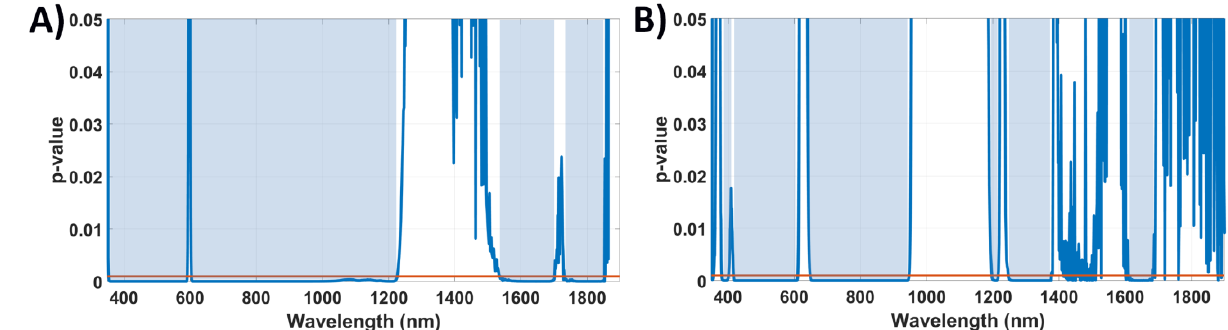
Figure 4. Selected spectral regions (blue) where statistically significant differences ( p < 0.001) are found for ( A ) short-SDD probe and ( B ) long-SDD probe. The red line indicates the 0.001 cutoff for the p -value.